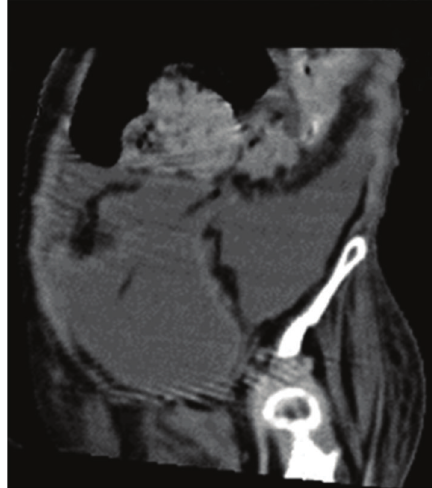
Figure 2: Free peritoneal fluid.